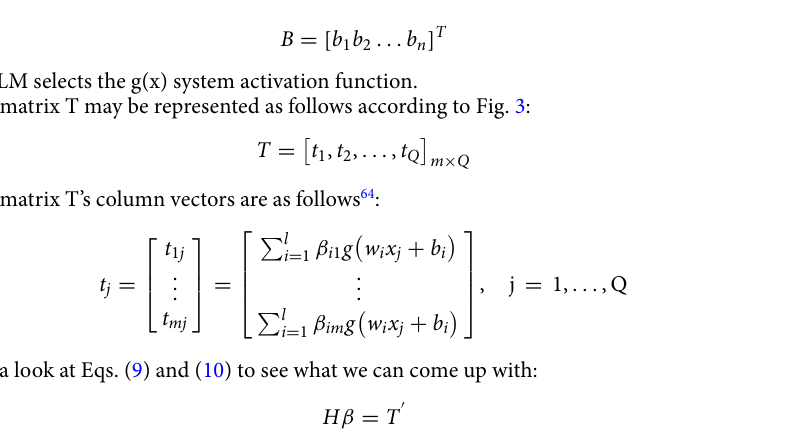
Figure 3. Schematic of the structure of